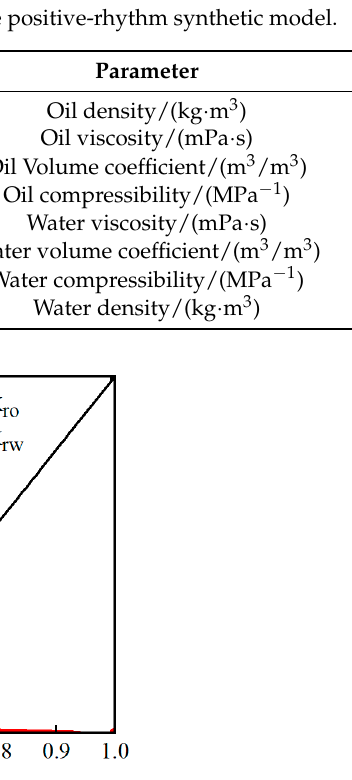
Figure 3. Oil–water relative permeability curves used for two-phase flow simulation.